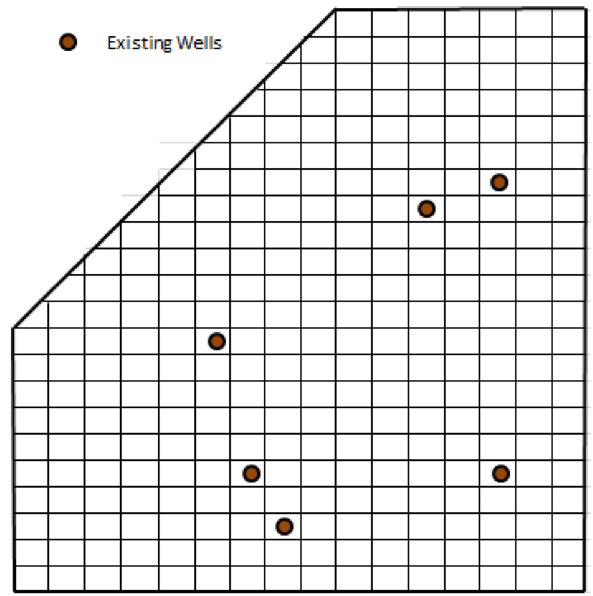
Fig. 7 Locations of existing wells in the reservoir model